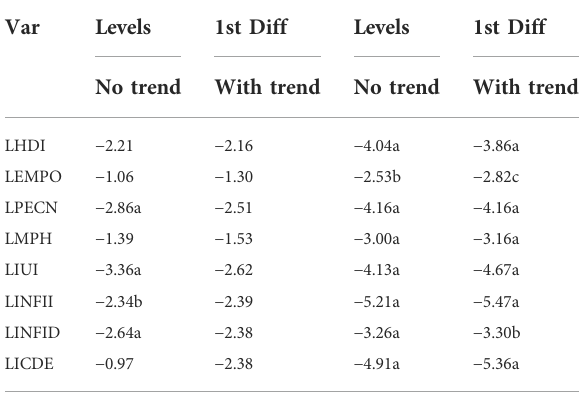
TABLE 4 Unit root